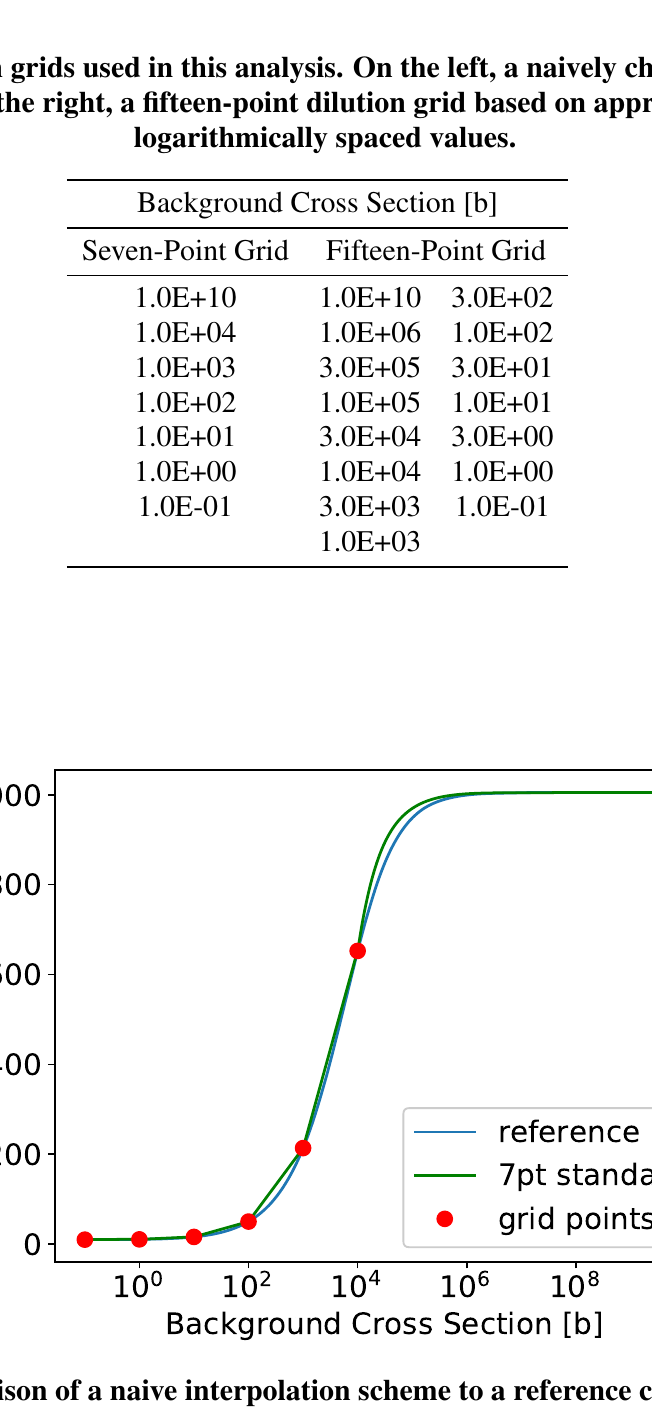
Figure 1: Comparison of a naive interpolation scheme to a reference curve for the U-238 cross section in an energy group containing the 36 . 6 eV resonance. Deviations are clearly seen at the